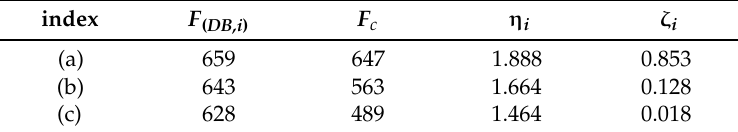
Table 4. Feature number and matching factors.